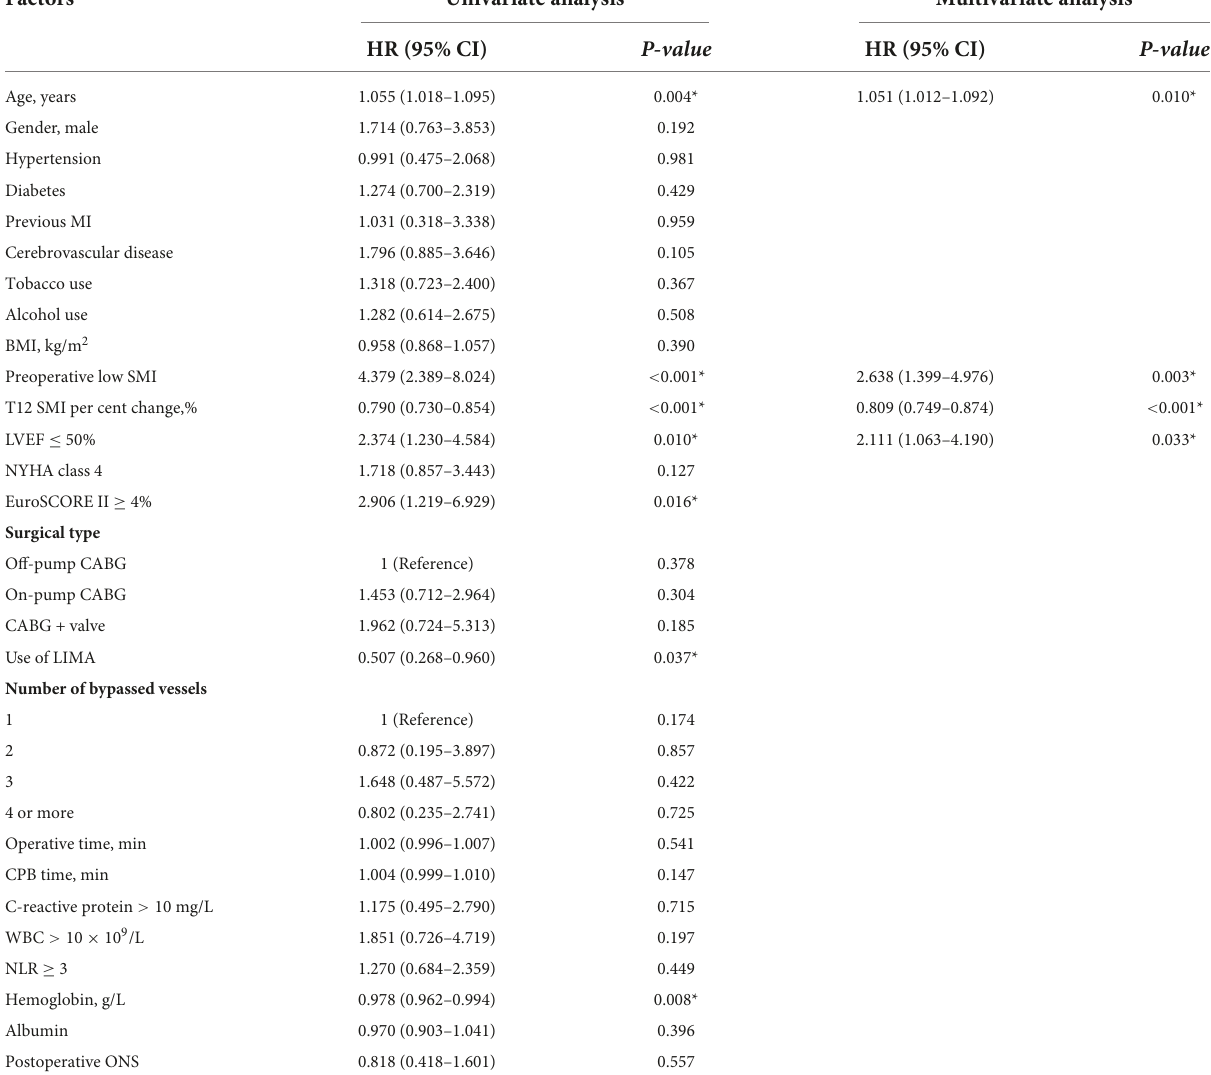
TABLE 2 Univariate and multivariate analyses for predictors of overall